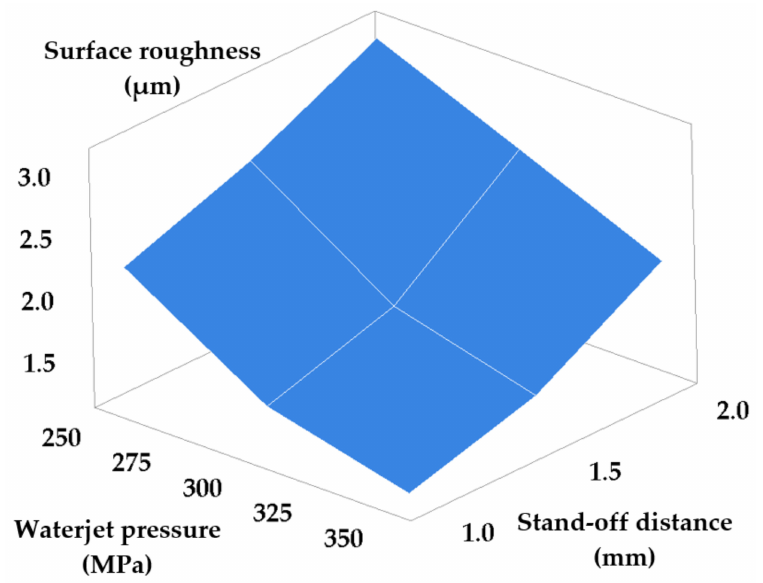
Figure 7. Roughness versus waterjet pressure and stand-off distance set-point modification.